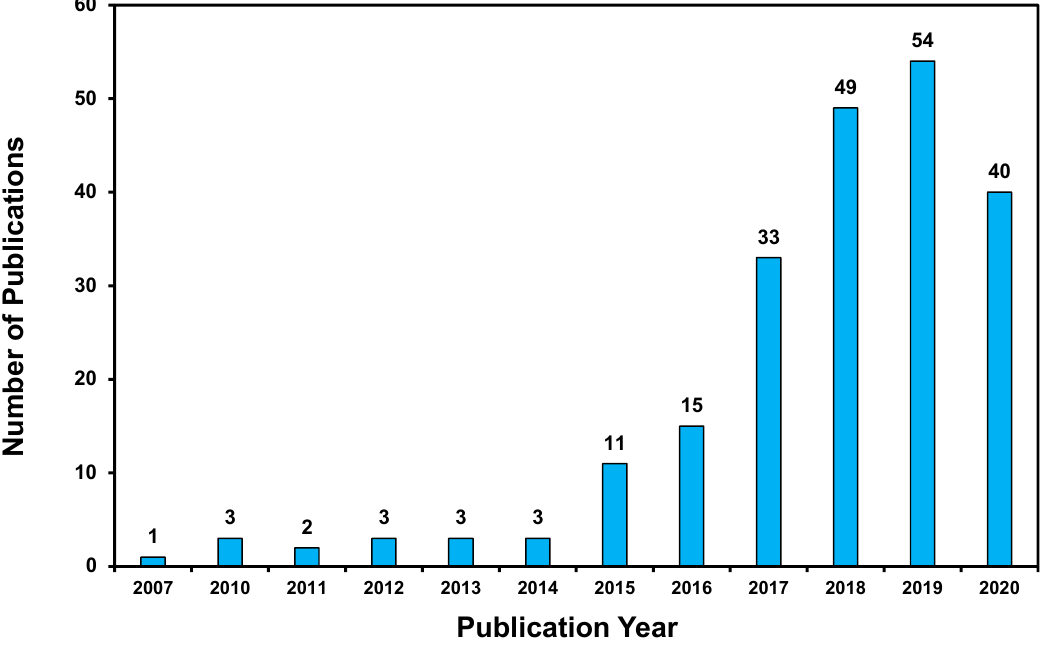
Figure 2. Number of papers on eutectic solvents in liquid–liquid extraction processes from 2007 to 2020 (internet search on Scopus, 15 June 2020). Keywords: “eutectic solvents” and “liquid–liquid extraction.”